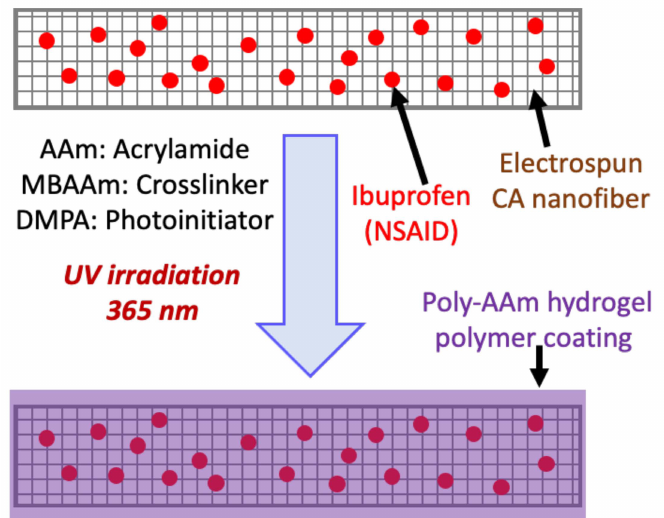
Figure 1. Schematic representation indicating the fabrication of CANFs loaded with ibuprofen drug and coated with poly-AAm hydrogel via two consecutive